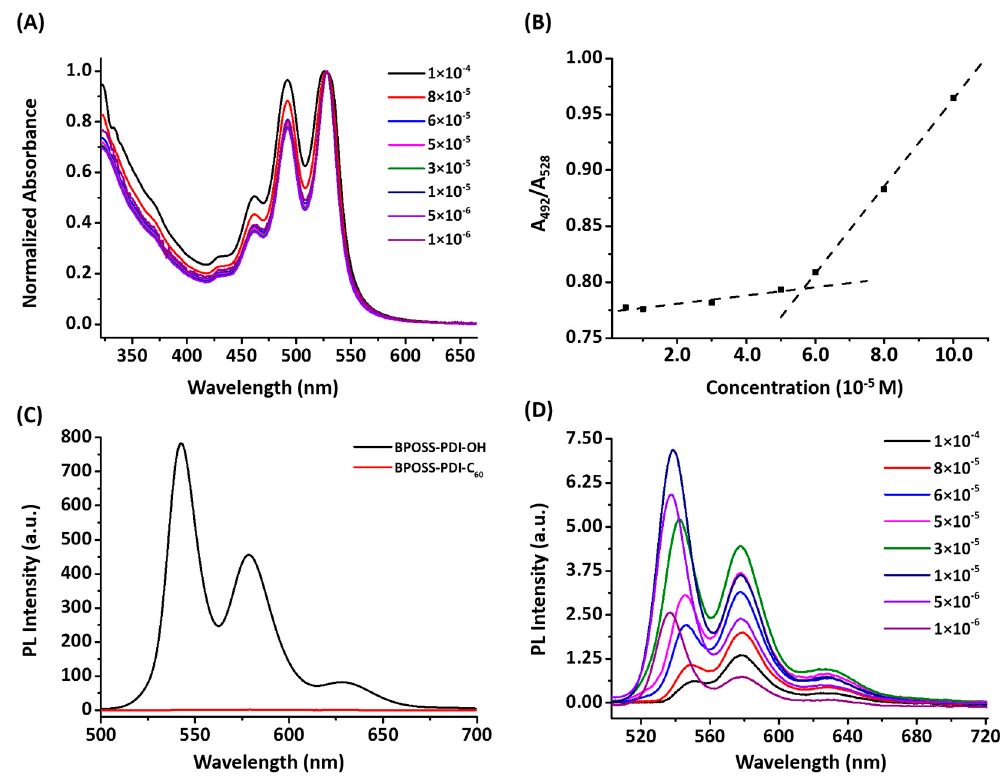
Figure 5. ( A ) Concentration-dependent UV/Vis absorption spectra of BPOSS-PDI-C 60 in CHCl 3 at concentrations from 1.0 × 10 − 6 M to 1.0 × 10 − 4 M. ( B ) Plot of the ratio of absorbance ( A 492 / A 528 ) versus concentration. The two linear dashed trend lines are included to illustrate the transition. ( C ) Fluorescence spectra of BPOSS-PDI-OH and BPOSS-PDI-C 60 at the same concentration of 1.0 × 10 − 5 M, showing significant quenching effect of the C 60 moiety. ( D ) Photoluminescence spectra of BPOSS-PDI-C 60 in CHCl 3 at concentrations from 1.0 × 10 − 6 M to 1.0 × 10 − 4 M.